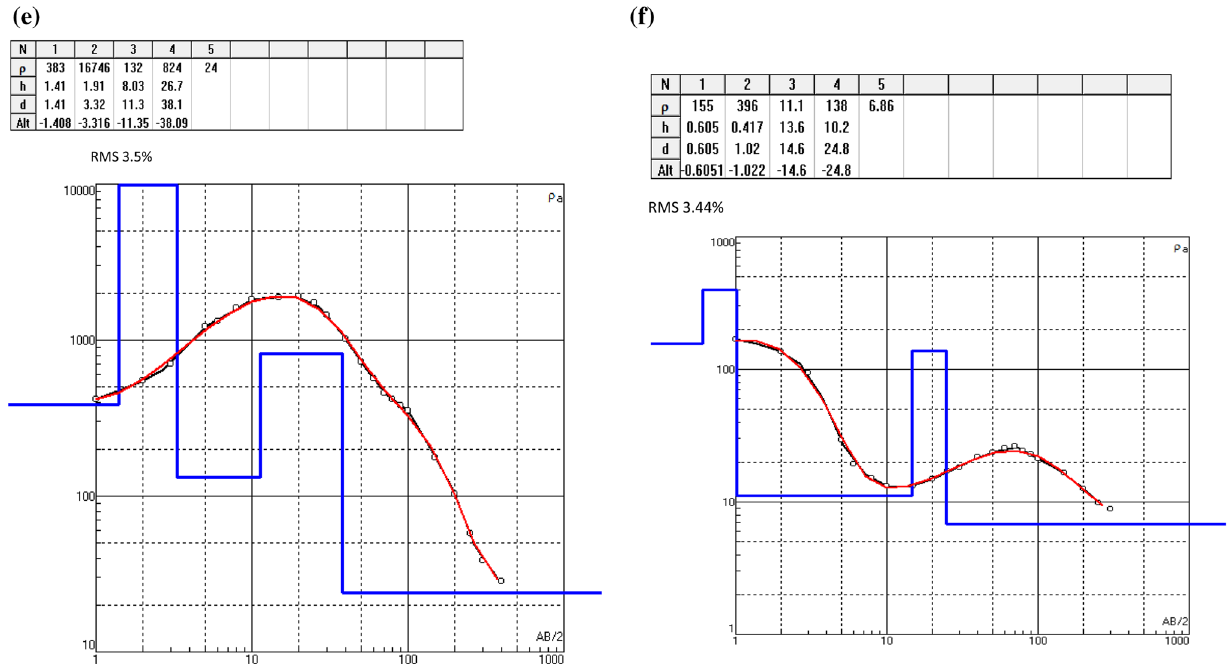
(Fig. 4d) are the least curve types, with 2% each. Variation